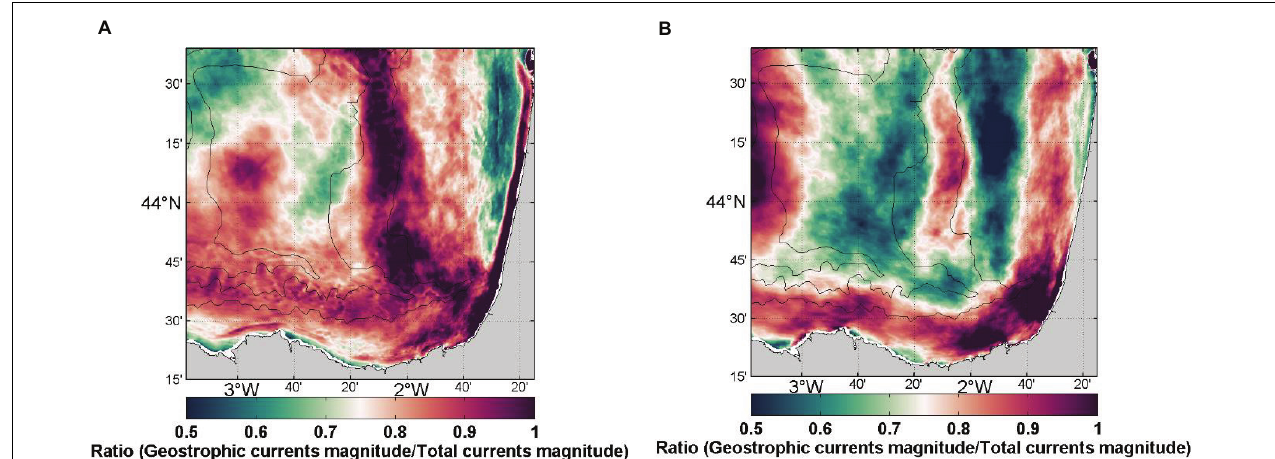
FIGURE 12 | Mean ratio over winter (A) and summer (B) of the geostrophic current magnitude over the total surface current magnitude. Winter is from October 2011 to January 2012 and from October 2012 to December 2012, from the simulation. Summer is from May to September. The 100, 200, and 2000 m isobaths are